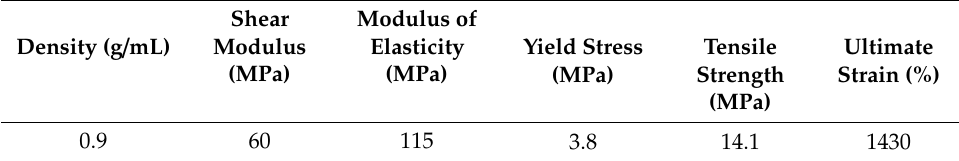
Table 2. Properties of the adhesive film Collano 22.001.